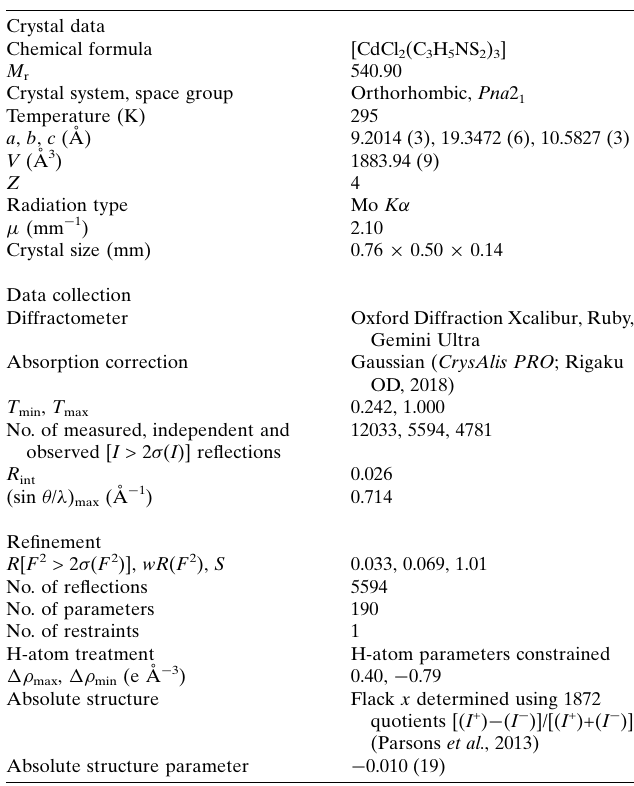
Table 1 Hydrogen-bond geometry (A˚ , (cid:5) ).